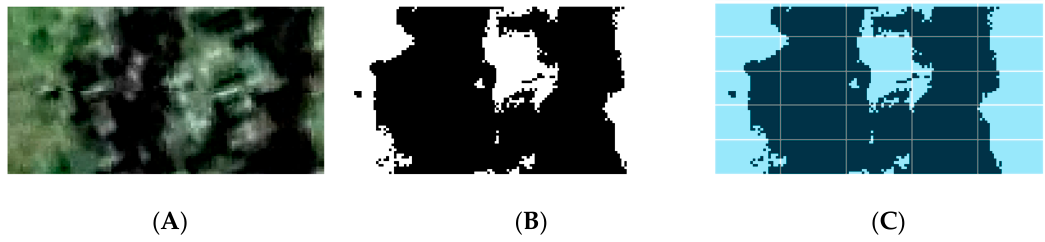
Figure 3. Analysis process from automatically cropped images per tree ( A ) and segmentation using the CieLab color code to obtain a binary image showing main tree biomass ( B ), and sub-division of 5 × 5 for gap analysis ( C ) and application of image analysis algorithms (Equations (1)–(6)).